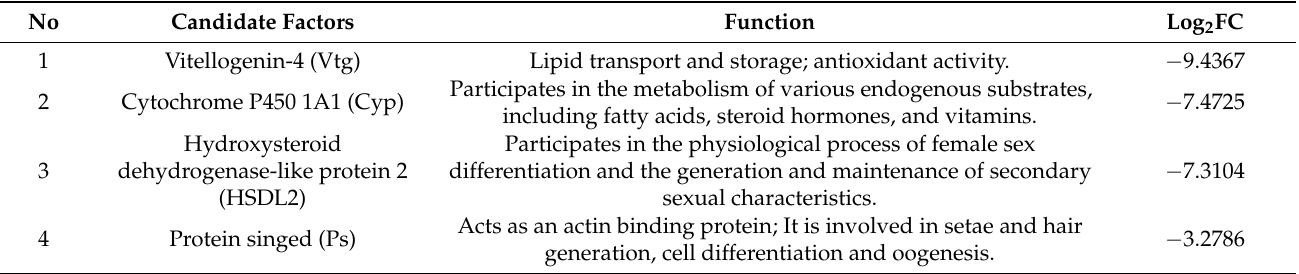
Table 1. Function of the candidate factors and their expression difference between ovaries and